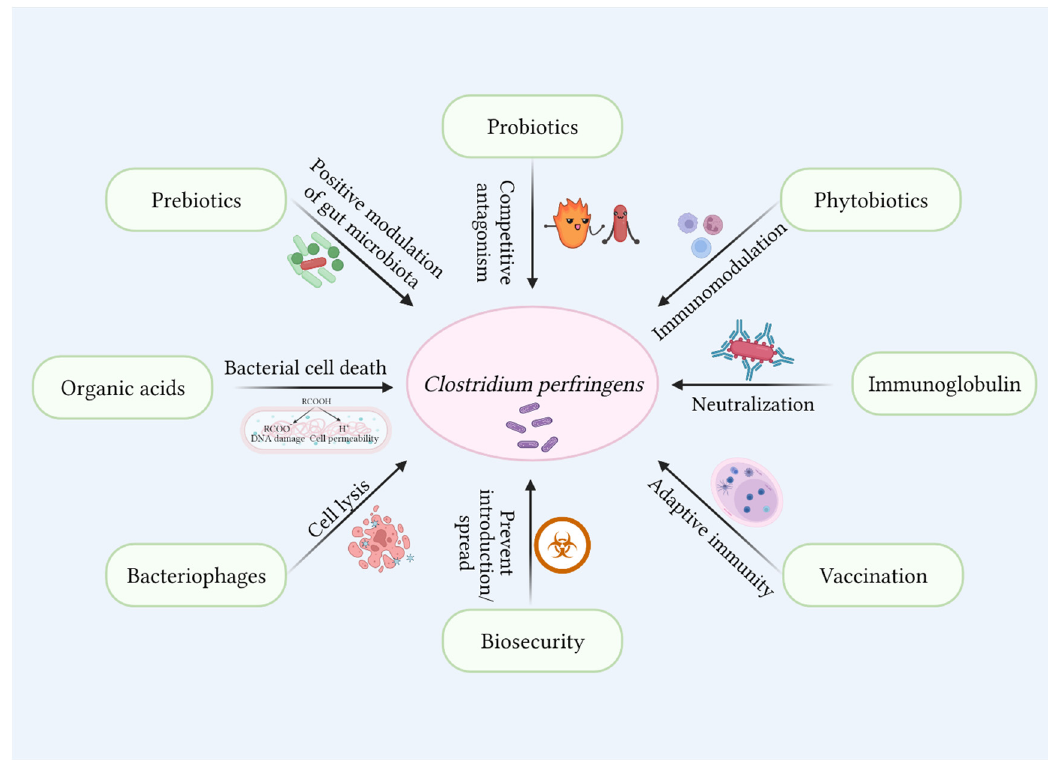
Figure 5. Prevention and control strategies of necrotic enteritis in the post-antibiotic age. Created with Biorender.com (accessed on 24 July 2022).